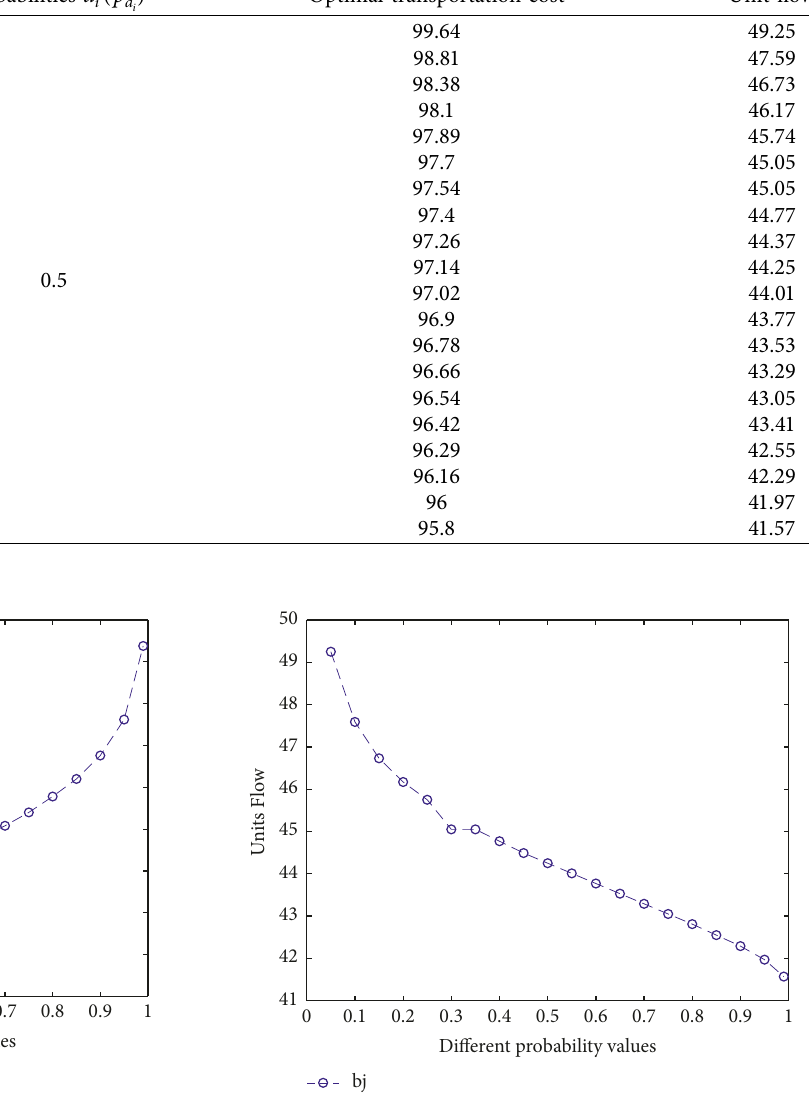
Figure 1: SA of the optimal transportation cost.